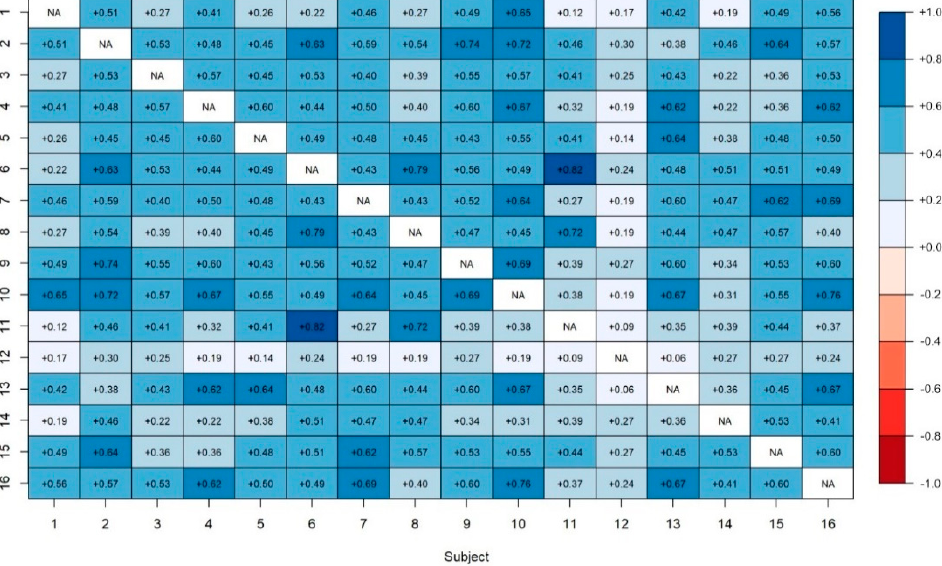
Figure 1. Inter-Coder Agreement ( α = 0.462). The boxes carrying unavailable values (NA) are produced as a result of the comparison of one subject with himself/herself. As for the remaining boxes, the more the α approaches 1, the higher the agreement between subjects is. On the contrary, values of α close to 0 signal a very low